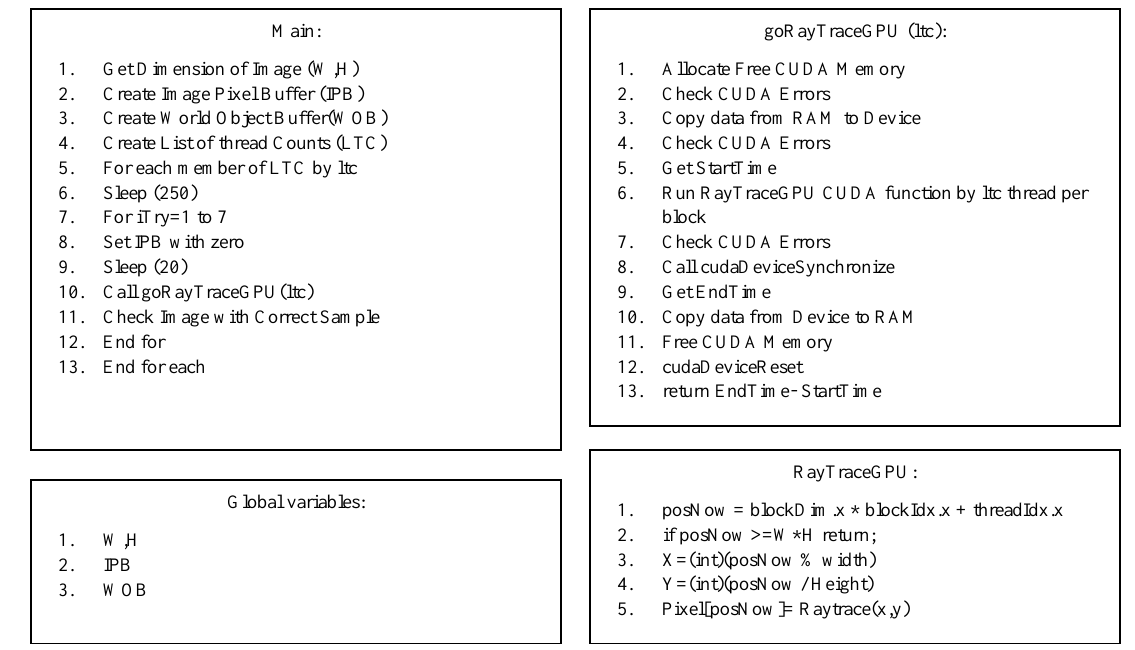
Figure 8. Pseudocode of raytrace alghorithm by